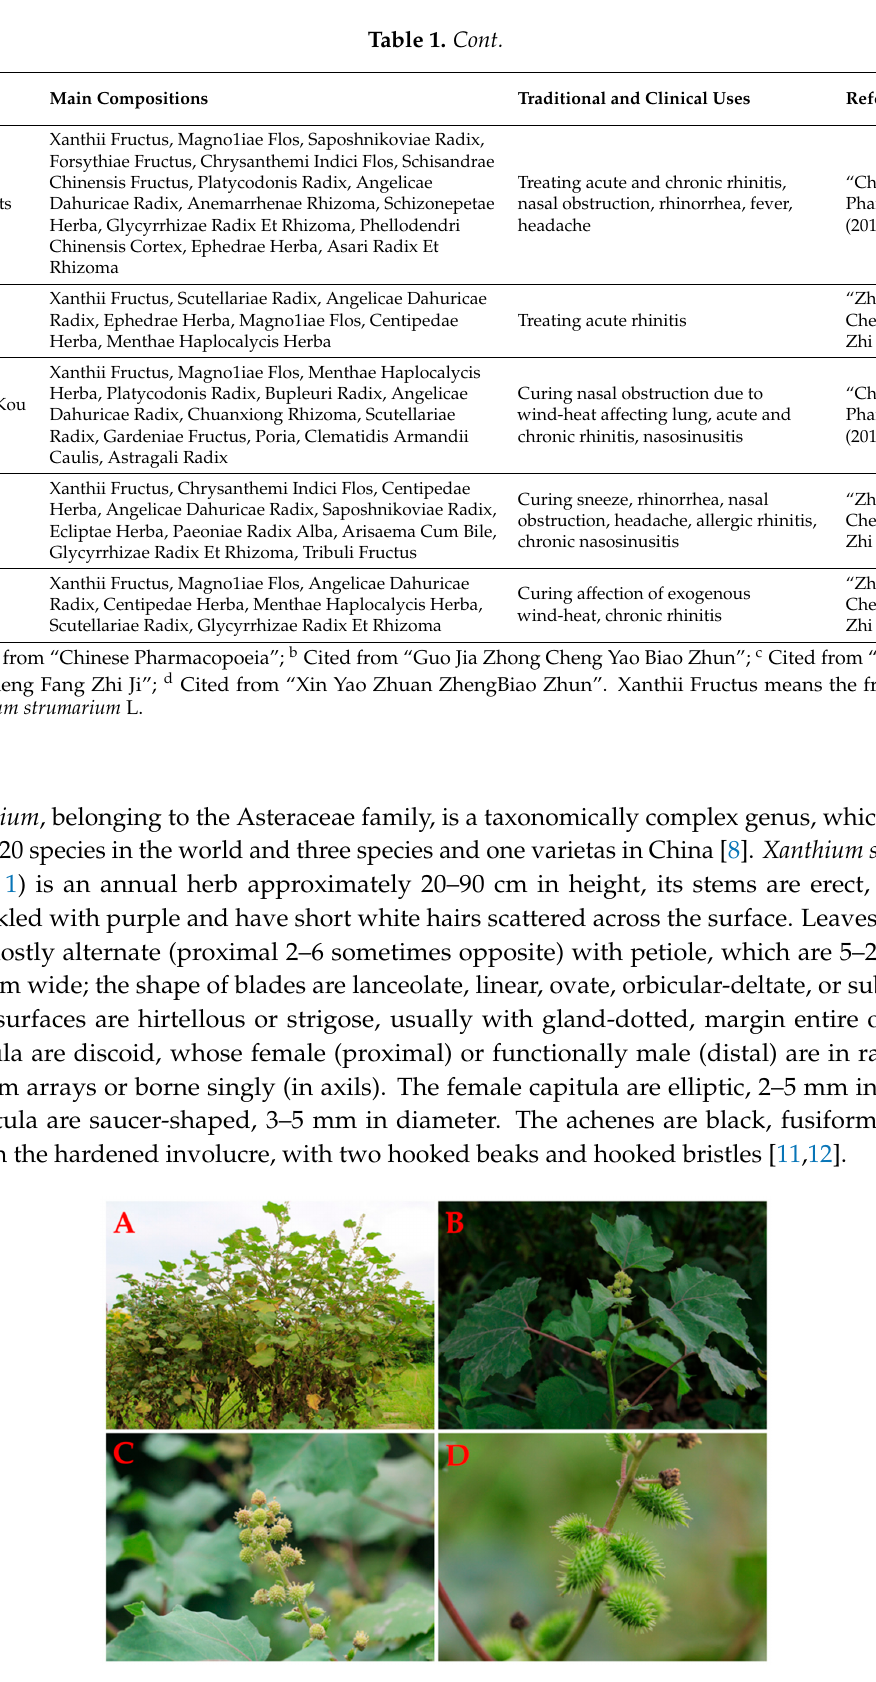
Figure 1. Xanthium strumarium L. A–D represent the whole plants ( A ), leaves ( B ), inflorescence ( C ) and fruits ( D ) of X. strumarium L.